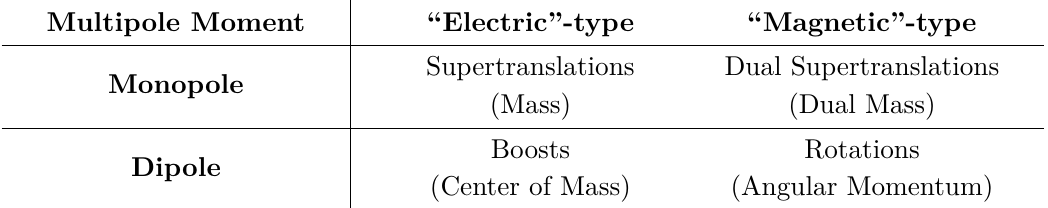
Table 1 . The extended BMS algebra includes supertranslations, dual supertranslations and Lorentz transformations. This group of symmetries can be classified using two properties: parity and multipole moments. The charge generators of the symmetry operations are mentioned in